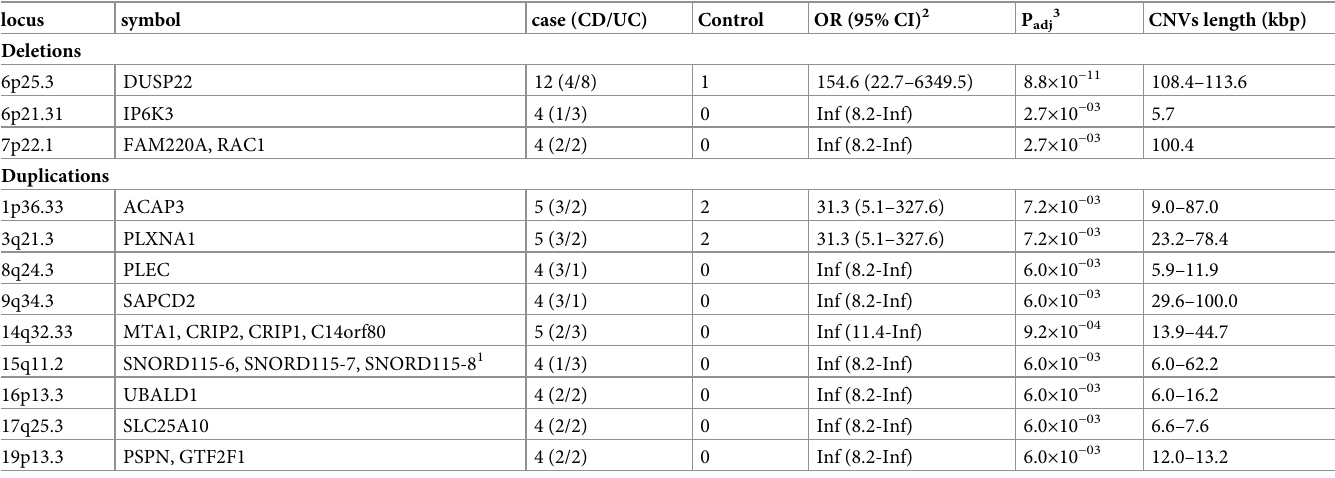
Table 2. The genes affected by rare CNVs overrepresented in IBD